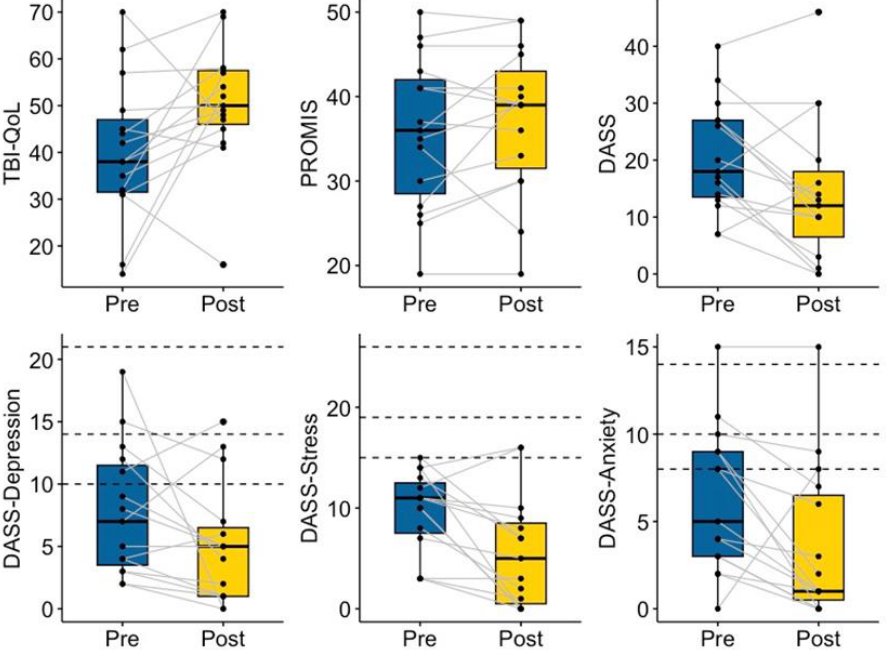
Figure 6. Mentee Pre- and Post-Mentoring Mental Health. Dotted lines indicate recommended cutoff scores for mild, moderate, and severe symptom presentations [54].